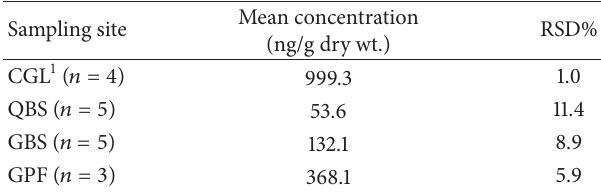
Table 1: Concentration of BDE-209 in different sites.